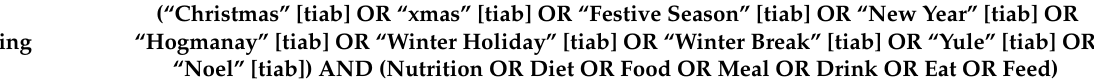
Table 1. Search string & Inclusion/Exclusion